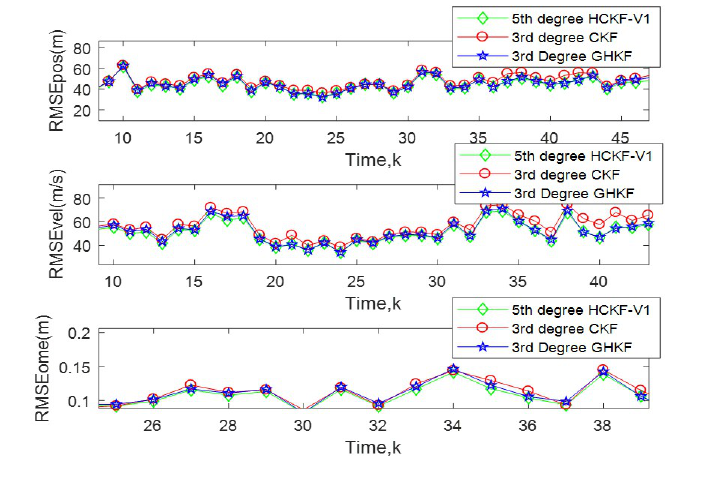
Figure 23. Performance comparison of 5th degree CKF non-linear filter with EKF, UKF, and CDKF for UAV tracking